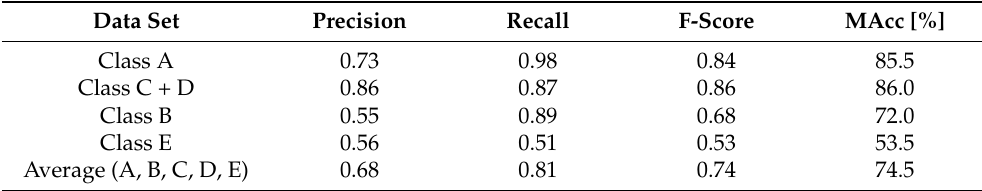
Table 4. ANFIS performance on the dataset.